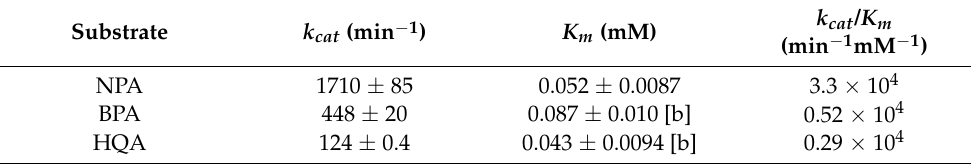
Table 1. Kinetic parameters of RgDAAO reactions [a].